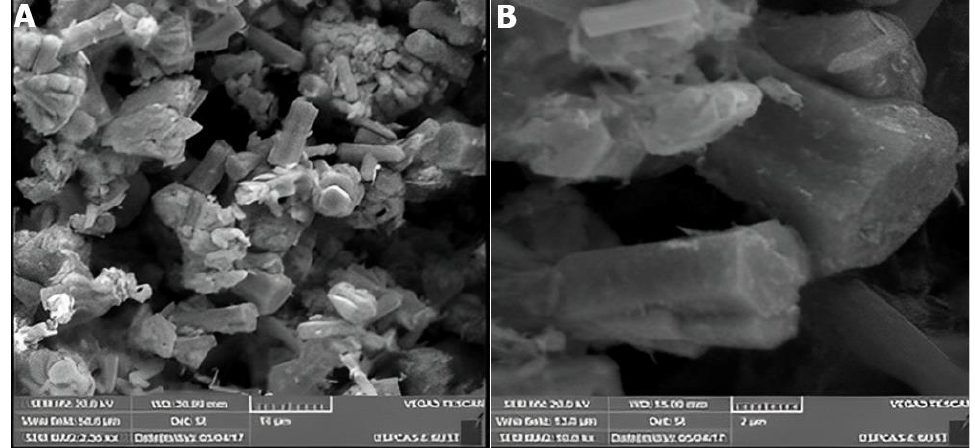
Figure 10. SEM images of ZnO nanorods synthesized by the CBD method (( A )—10 µm, ( B )—2 µm).